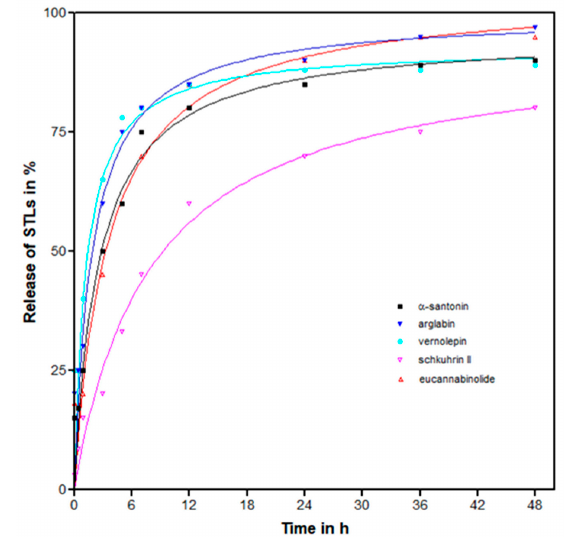
Figure 2. Sesquiterpene lactones (STLs) released over time from STL-PLA-NPs. Trendlines are polynomial (2 nd order) with R 2 values ≥ 0.90 in all cases.